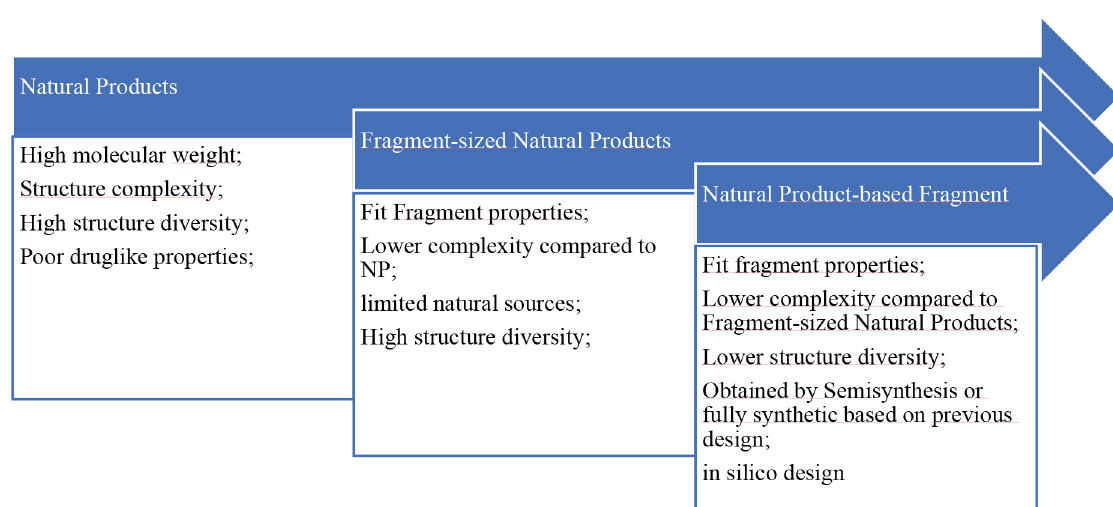
FIGURE 4 - Classification and definitions of natural and non-natural compounds according to structural features and fragment-like